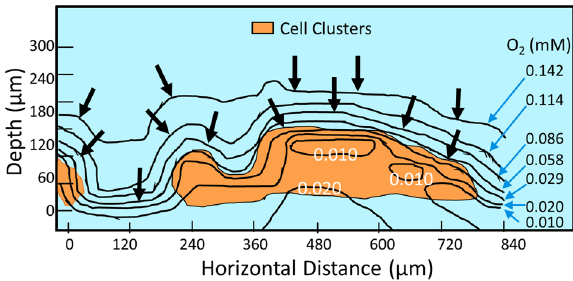
Fig. 6 Oxygen diffusion within a microcolony. Oxygen contours and local gradients in a cross section of a 160-µm-thick bio fi lm. The positions of the cell clusters, shown as orange areas, were determined by microscopic observation. Numbers within the fi gure and on the right margin indicate the local oxygen concentrations (mM). Reprinted with permission from ref. 106